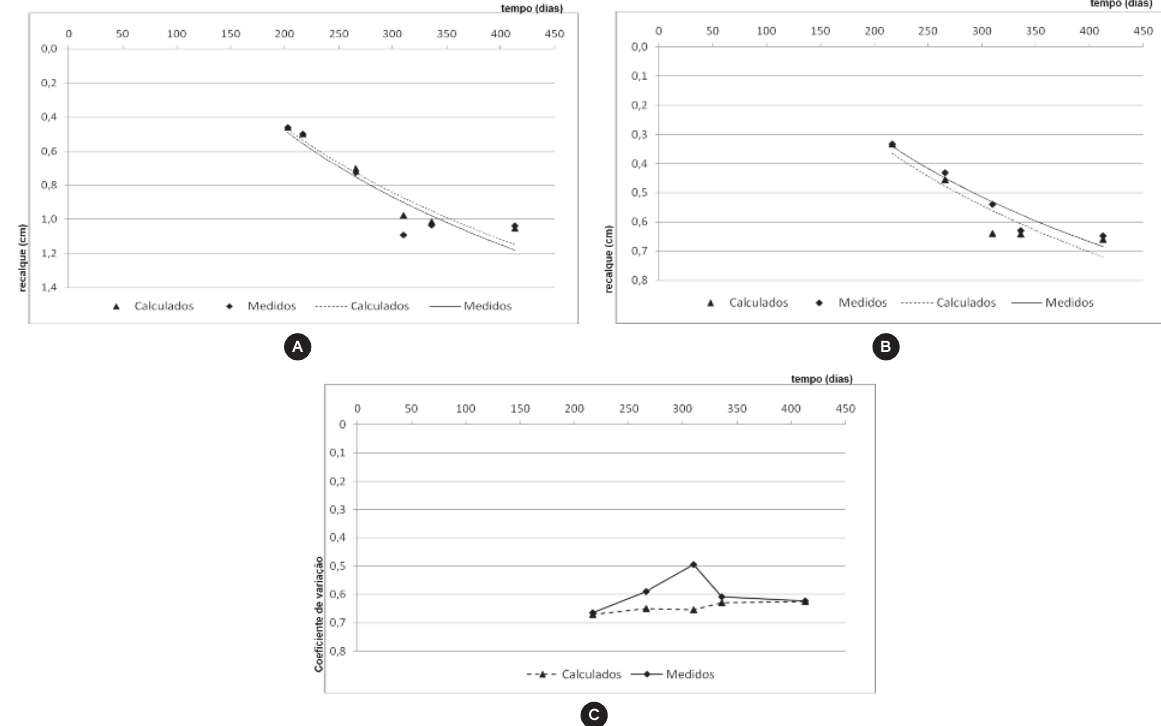
Figura 9 (a) Média, (b) Desvio padrão e (c) Coeficiente de variação dos recalques medidos e calculados